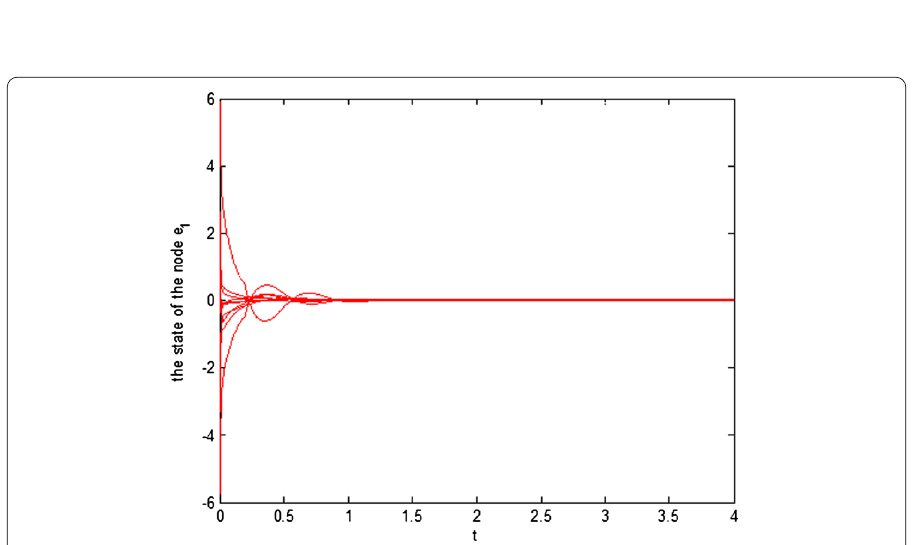
Figure 4 The state of the node e 1 with